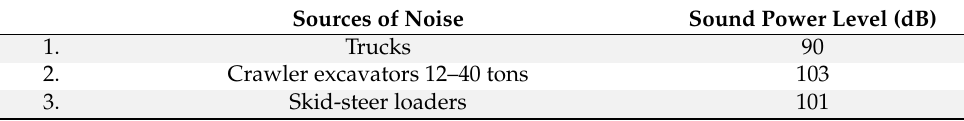
Table 10. Expected sources of construction noise.